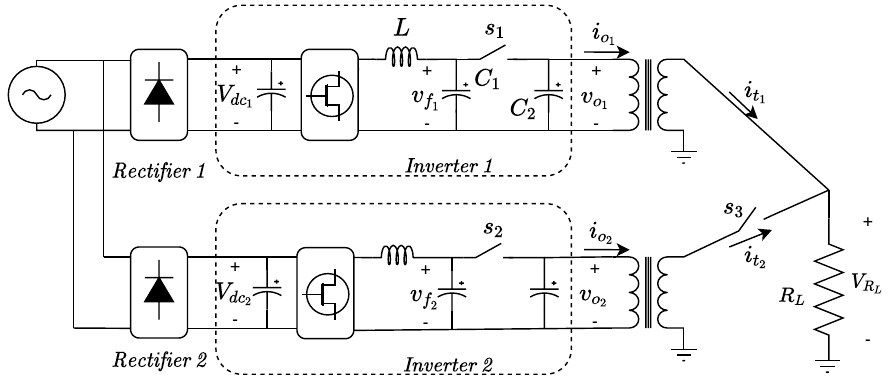
Figure 12. Schematic of the laboratory-scale prototype for testing the VOC.